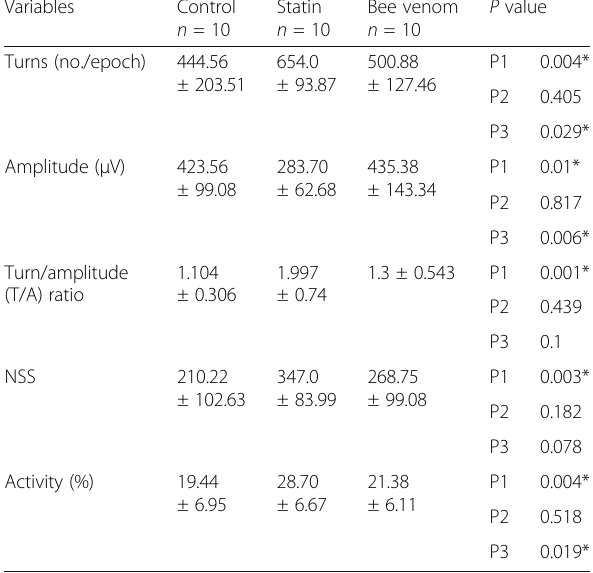
Table 1 Interference pattern analysis parameters of the quadriceps femoris muscle Variables Control n = 10